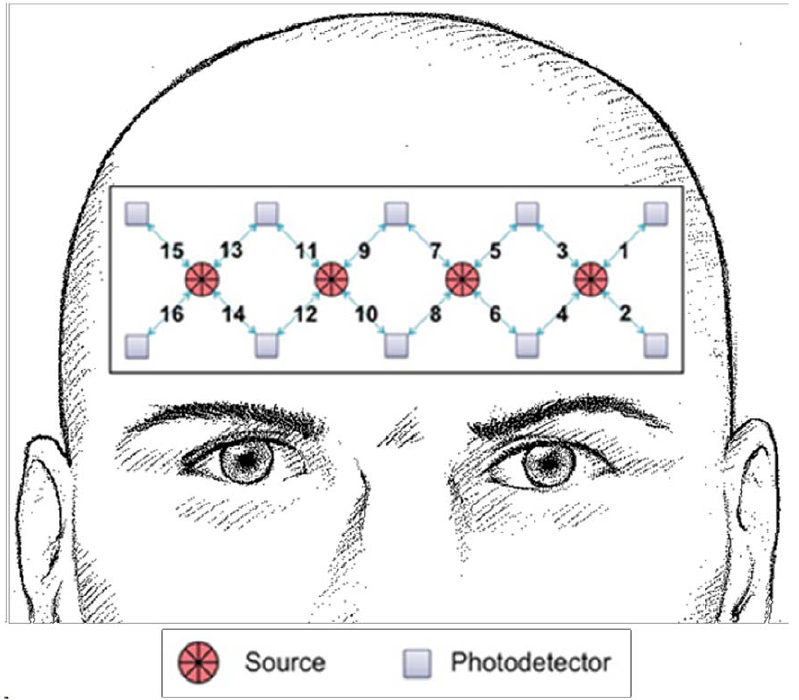
Figure 1. The fNIR Device model 1000. The fNIR head probe was applied to the participant’s forehead. The distribution of four light sources and 10 light detectors resulted in 16 channels.